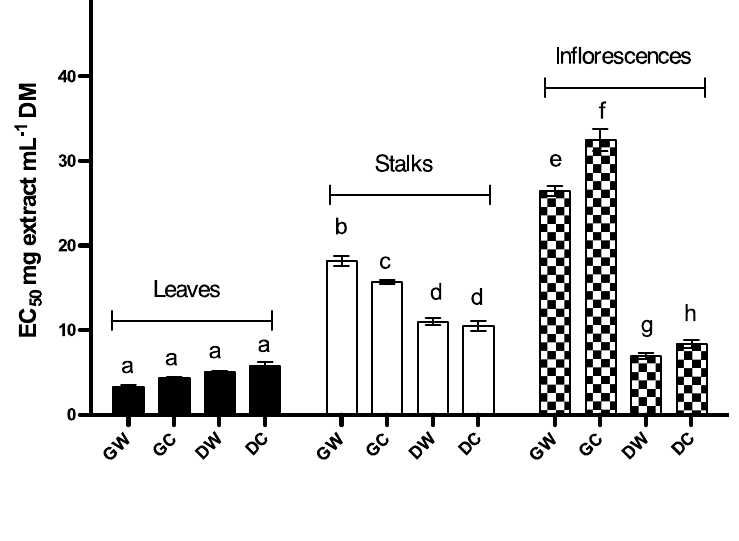
Figure 2. Reduction capacity of Cc extracts expressed in terms of EC represents the mean ± S.D. of three determinations. At least one same letter means no significant differences at P ≤ 0.05. Abbreviations: GW: green wild; GC: green cultivated; DW: dry wild; DC: dry